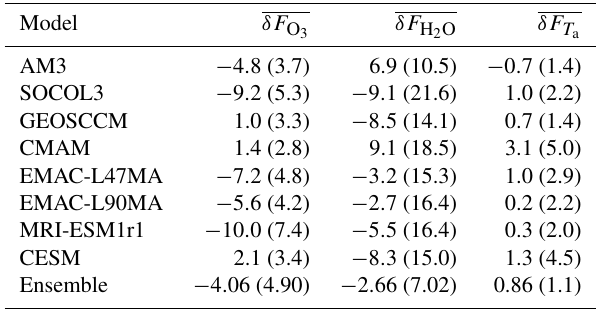
Table 4. Models’ flux bias (mWm − 2 ) in the tropic troposphere be- tween 25 ◦ S and 25 ◦ N, and below